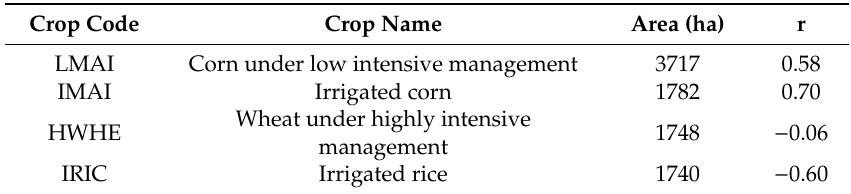
Figure 2. Comparison of simulated and observed annual crop yields from SPAM ( a ) and FAOSTAT ( b ) in the period 2000–2012. The acronyms of crop names are reported in Table A1 in Appendix A. Table 6. Pearson correlation coefficient (r) calculated between SWAT simulated annual crop yields and FAOSTAT in the period 2000-2012 for the main crops in the basin.